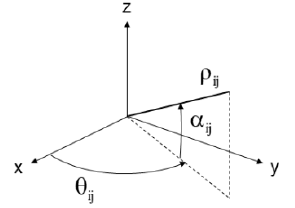
Figure 2. TLS spherical imaging geometry.